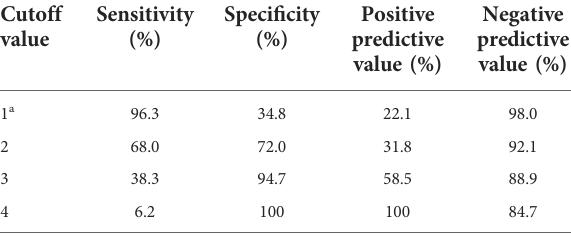
TABLE 3 Sensitivity, speci fi city, positive predictive value, and negative predictive value of the model with different cutoff values.